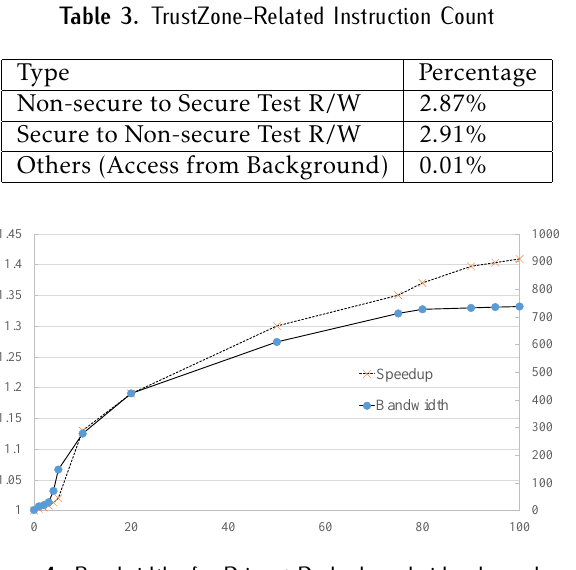
Figure 4. Bandwidth of a Prime+Probe based side-channel and performance improvement by allowing a specific ratio of cache operations passing through ARM